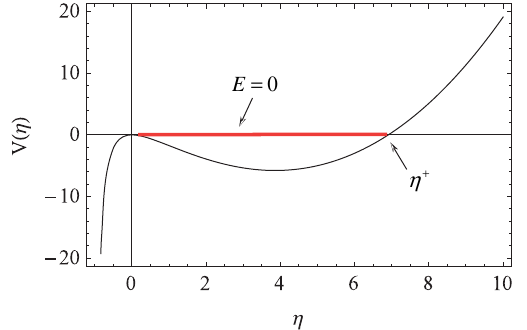
FIG. 6. Illustrative plot of V ð η Þ versus η obtained from Eq. (56) 1 = 50 . Here, η þ ¼ 6 . 908 , and the energy for M 2 ¼ 9 and ϵ T ¼ level E ¼ 0 corresponds to soliton solutions with maximum amplitude η þ ¼ 6 . 908 .